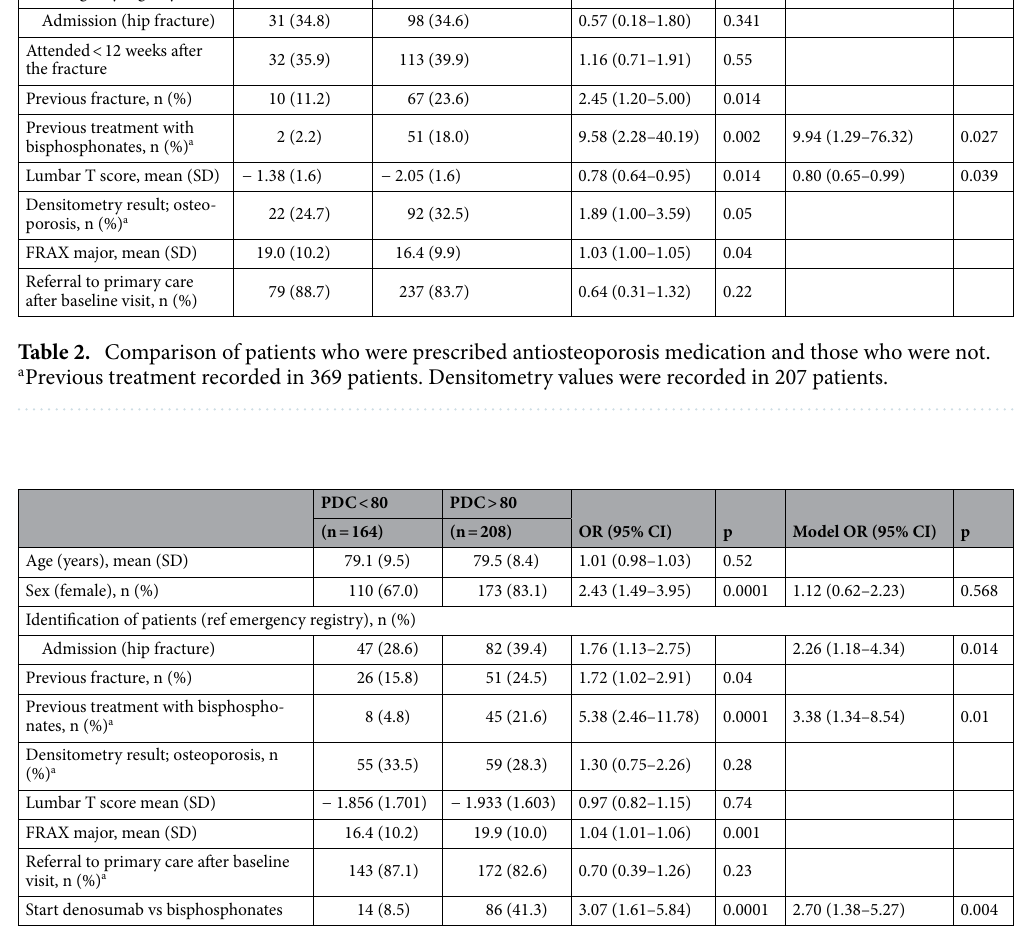
Table 3. Comparison of patients with proportion of days covered (PDC) with antiosteoporosis medication higher and lower than 80%. a Previous treatment recorded in 369 patients. Densitometry values were recorded in 207